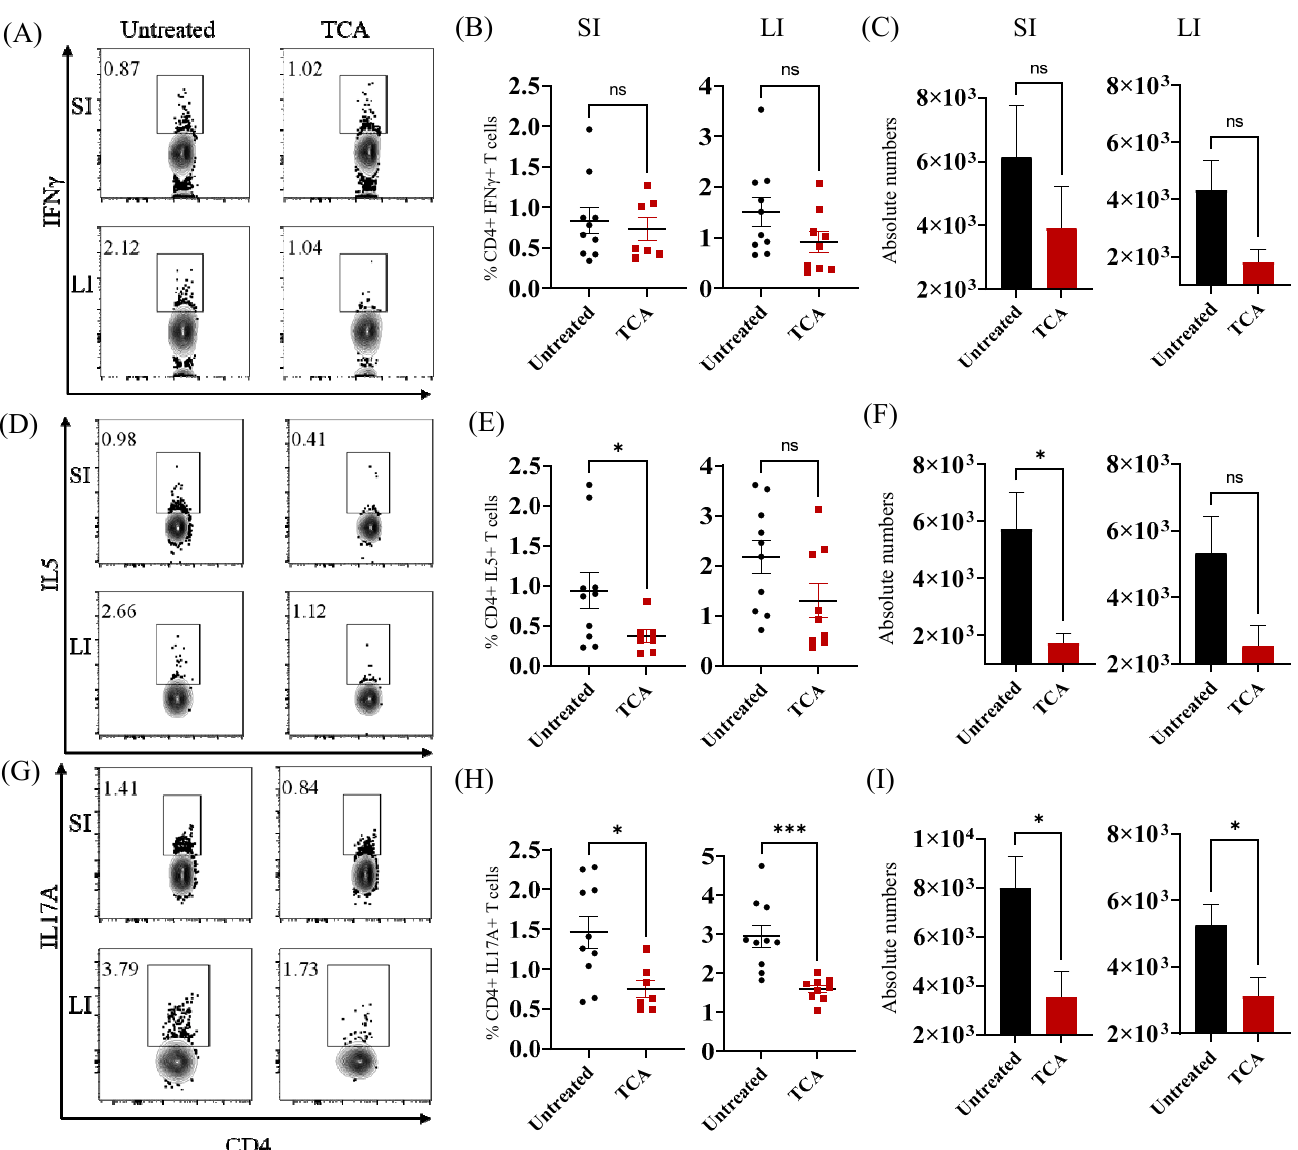
Figure 2. TCA significantly decreased Th2 and Th17 cells in the intestine. Groups of mice infected with ~1 × 10 7 CFU CA SC5314 via oral gavage. Control group received sterile drinking water and TCA group received drinking water containing 1% TCA. Eight days post-infection and treatment, mice were euthanized to isolated mononuclear cells from small and large intestine. Cells were labeled with indicated markers to determine Th1, Th2 and Th17 population in the intestine of CA-infected mice. ( A ) Representative images; ( B ) percentage and ( C ) absolute number of CD4+ IFN γ + T helper 1 cells from small intestine (SI) and large intestine (LI) of untreated and TCA-treated mice were shown. ( D ) Representative images; ( E ) percentage and ( F ) absolute number of CD4+ IL5+ T helper 2 cells from SI and LI of untreated and TCA-treated mice were shown. ( G ) Representative images; ( H ) percentage and ( I ) absolute number of CD4+ IL17A+ T helper 17 cells from SI and LI of untreated and TCA-treated mice were shown. Data shown are combined from 2 independent experiments for a total of 7 to 10 mice per group. Data represent mean ± SEM. The statistical signficance of differences between groups was determined by the Mann-Whitney U test with * p ≤ 0.05, and *** p ≤ 0.001.